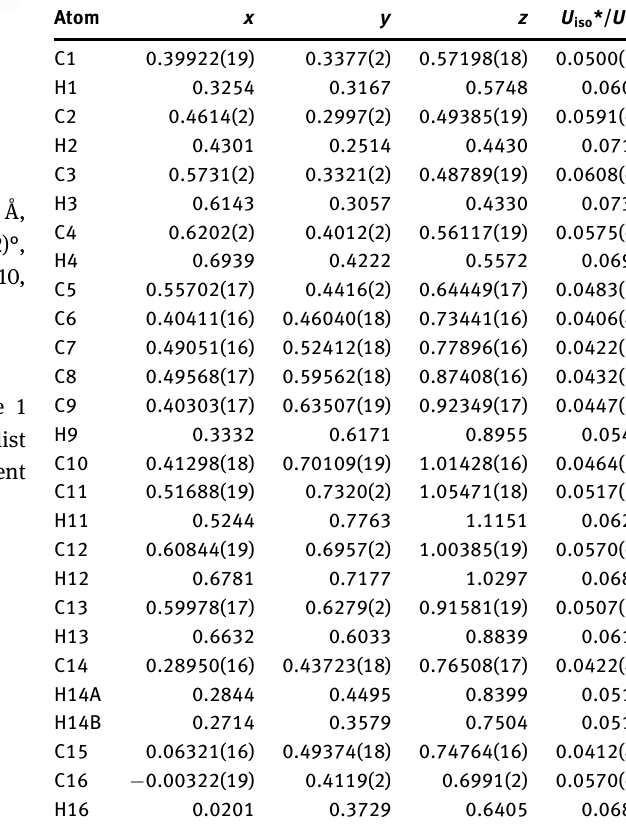
Table 2: Fractional atomic coordinates and isotropic or equivalent isotropic displacement parameters (Å 2